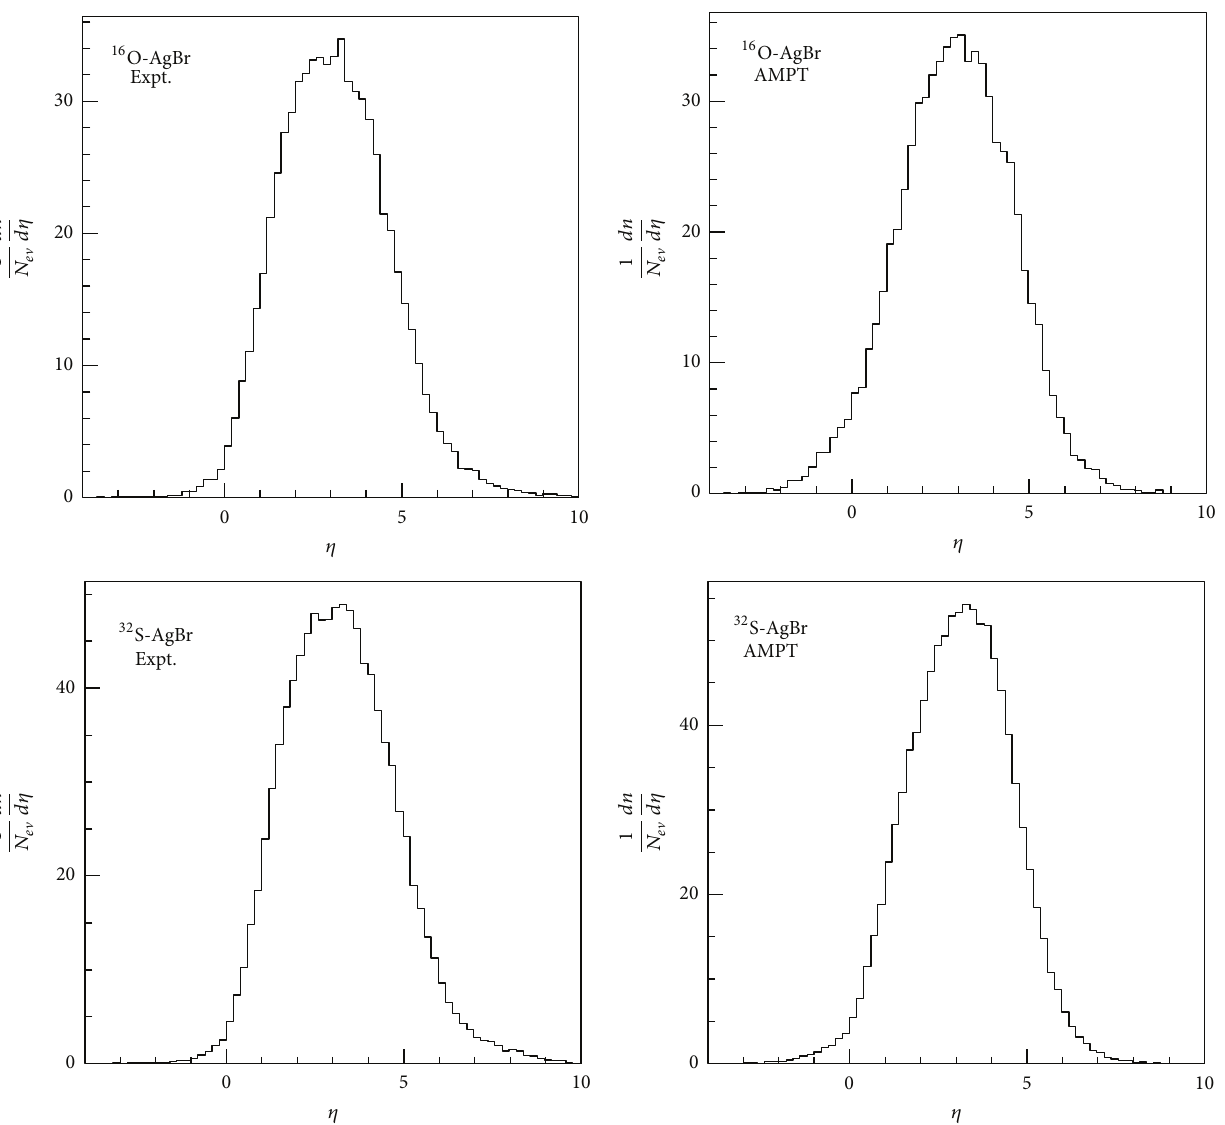
Figure 1: Pseudorapidity distributions of relativistic charged particles produced in 16 O- and 32 S-AgBr collisions compared with AMPT predictions.